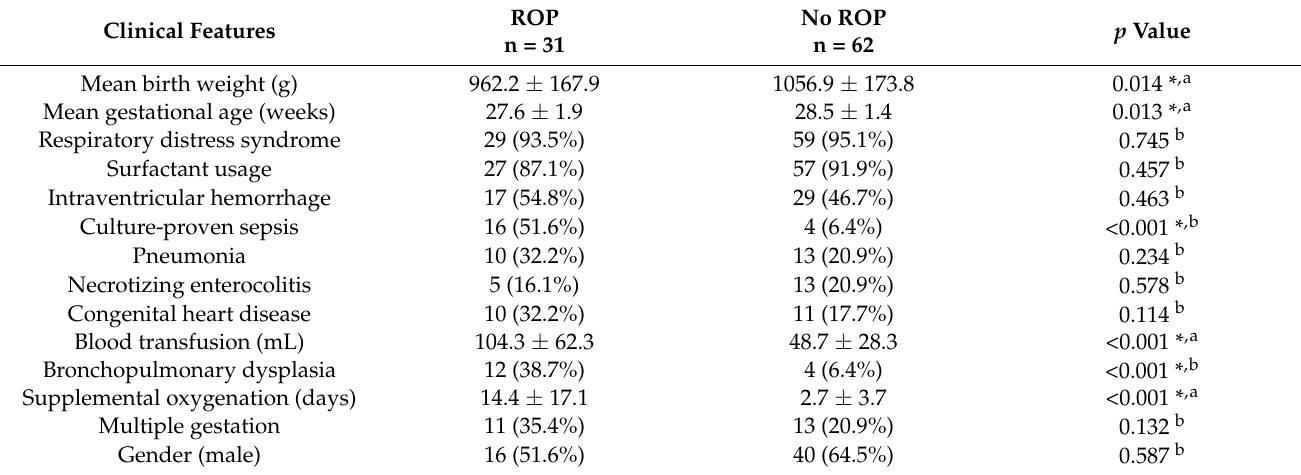
Table 1. Clinical characteristics of infants with and without retinopathy of prematurity (ROP).